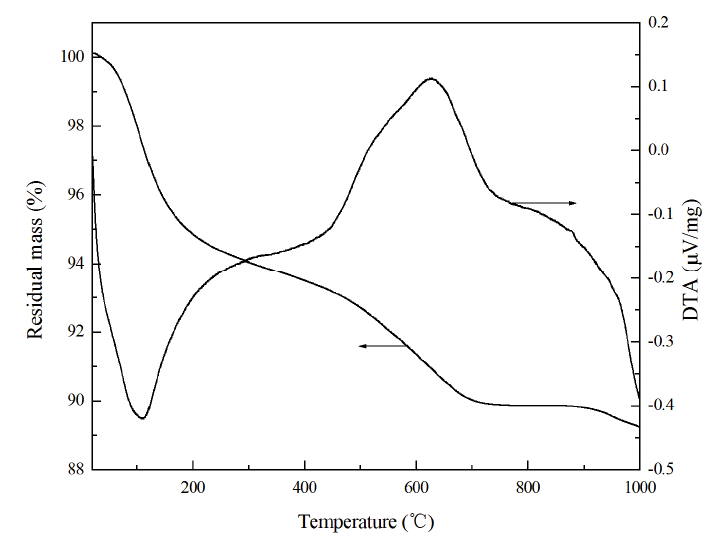
Figure 8. TG-DTA curves of selected GLWC curing for 28 days.